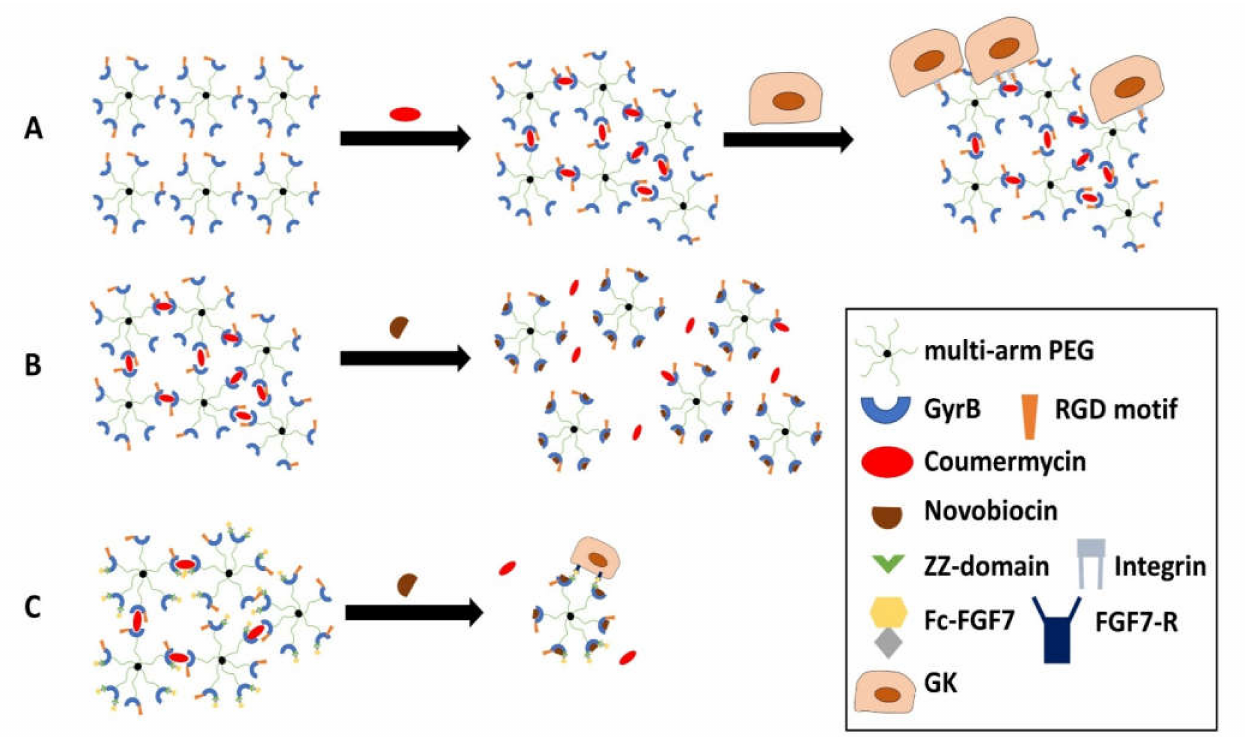
Figure 3. Illustration of the polyethylene glycol (PEG)-based, pharmacologically tunable “smart” hydrogel. ( A ) Multi-arm PEG (green asterisk-like structure) was used as a backbone for the hydrogel. It was chemically coupled to Gyrase B (GyrB; blue hemicycle) and the arginine–glycine–aspartate binding motif (RGD motif; orange bar) from fibronectin. Upon the addition of coumermycin (red ellipse), GyrB molecules can dimerize, which leads to hydrogel assembly. Subsequently, cells (as exemplarily represented by gingiva keratinocytes (GKs)) can be seeded on the hydrogel, which can bind to the RGD motif via membrane-inherent integrin receptors (grey receptors). ( B ) Dissociation of the hydrogel is induced by adding novobiocin (brown hemicycle). Novobiocin competes with coumermycin for the GyrB binding sites. Contrary to coumermycin, novobiocin does not lead to dimerization of the GyrB molecules. Excess amounts of novobiocin, therefore, lead to the disassembly of the hydrogel. ( C ) When additionally coupled with the ZZ-domain of Protein A (green triangle), the multi-arm PEG can bind fibroblast growth factor 7 (FGF7), which is modified with Fc (crystallizable fragment of antibodies; yellow/grey construct). When adding novobiocin, the hydrogel disassembles and FGF7 can then bind to FGF7 receptors (FGF7-R; dark blue receptor) on cells such as GKs. Details are given in the main text. A graphic legend is included in the lower right